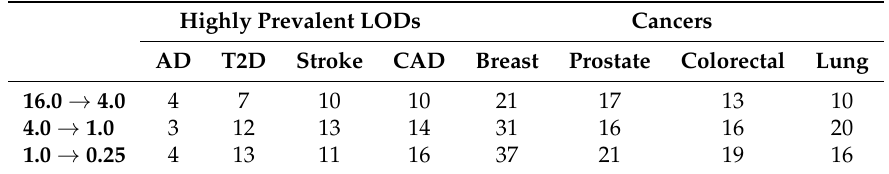
Table 2. Estimate of LOD onset delay of incidence slope at 30% of lifetime risk (values in years).